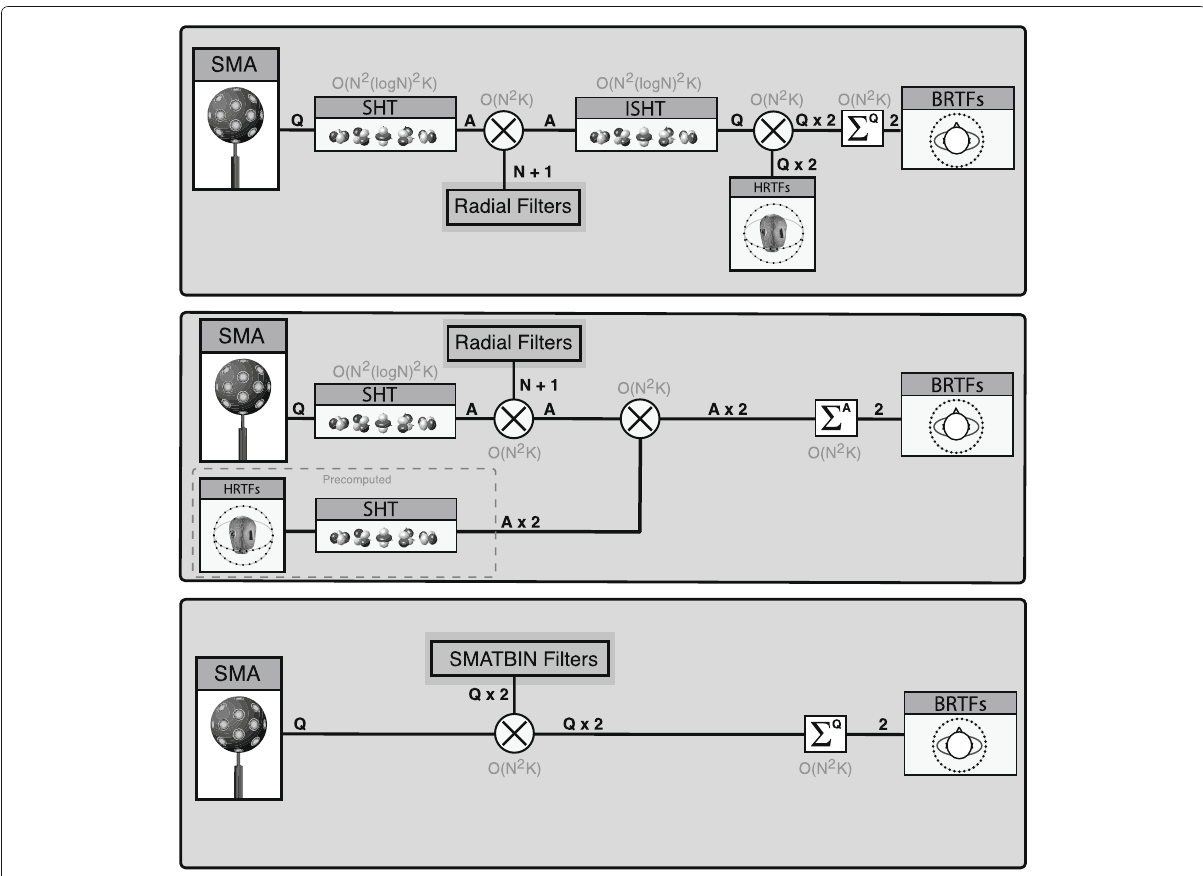
Fig. 1 Block diagrams illustrating the signal processing in the temporal frequency domain for binaural rendering of SMA data using the virtual loudspeaker approach (top), the SH domain approach (middle), and the proposed SMATBIN filter approach (bottom). N : spatial order, Q : number of microphones, A : number of SH channels, O : Landau’s symbol, K : FFT size (top, middle) or SMATBIN filter length